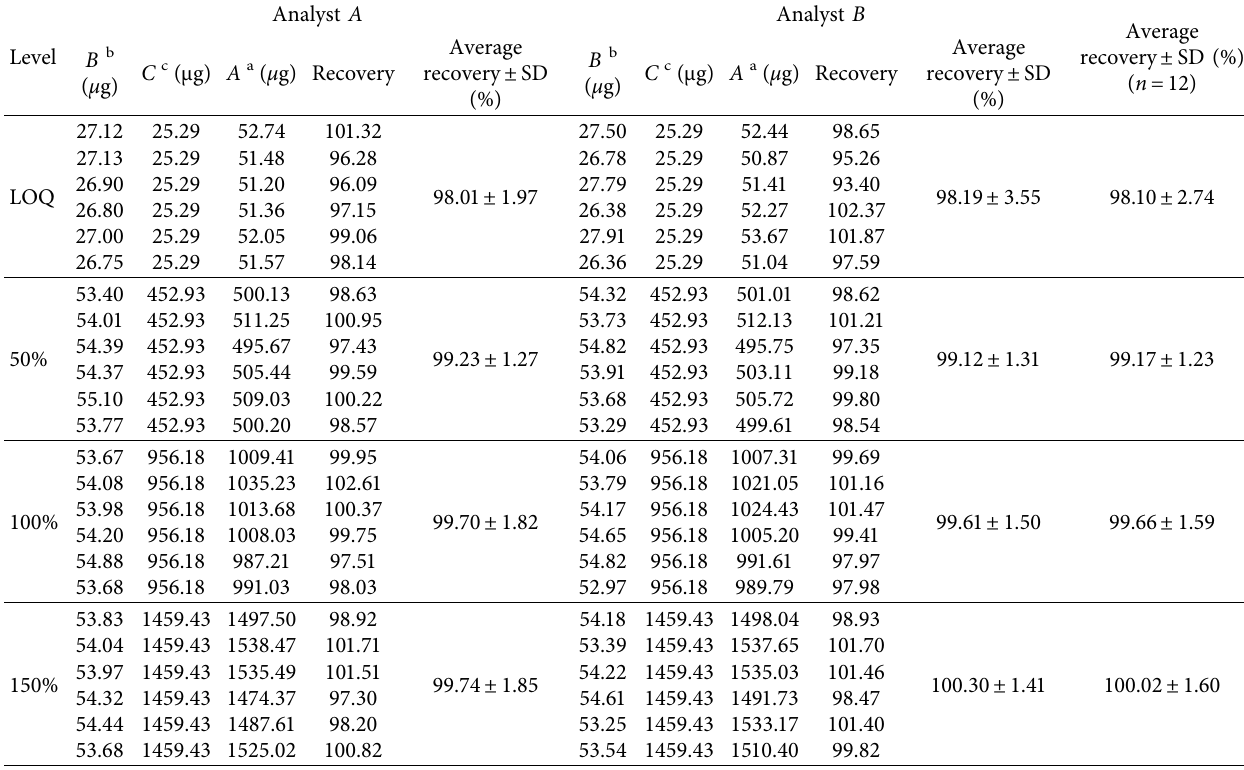
Table 4: Accuracy results by standard addition technique for the HPLC-RID method.